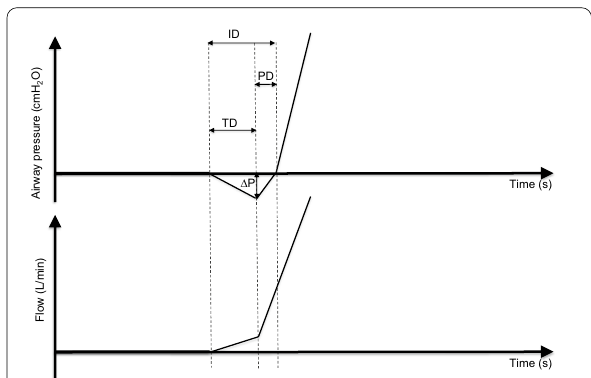
Fig. 2 Explicative figure of ventilator triggering assessment. The figure illustrates ventilator triggering assessment. Airway pressure (Paw) and flow are displayed. Triggering delay (TD) is the delay between the onset of airway pressure drop (“patient” effort) and flow delivery by the ventilator. Pressurization delay (PD) is defined by the time at which the airway pressure comes back to the level of PEEP. The addition of TD and PD gives the inspiratory delay (ID). The drop of airway pressure (∆ P ) due to patient effort is also shown on the